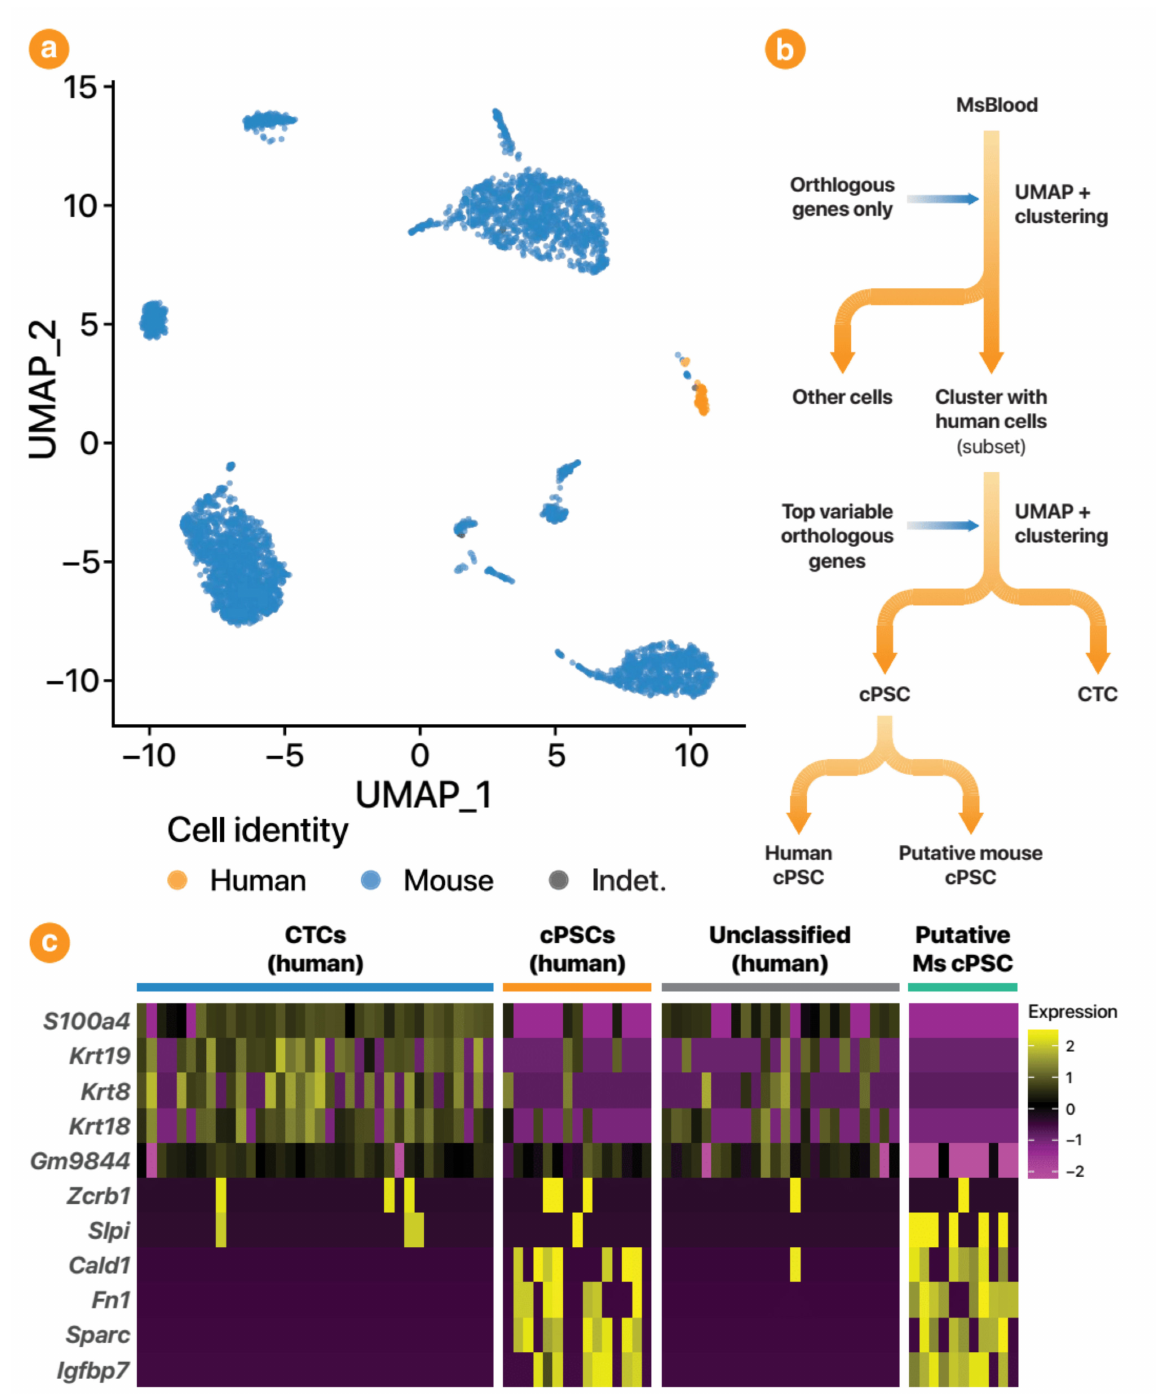
Figure A11. Potential mouse cPSCs in MsBlood sample. ( a ) Gene expression analysis restricted to one-to-one orthologous genes of cells in the MsBlood sample is summarised in the UMAP plot above. Clustering close to the human cells are a number of mouse cells which possibly represent mouse cPSCs. ( b ) This subset of cells were analysed by unsupervised clustering into three groups: PSCs, CTCs and unclassified (non-specific expression pattern). ( c ) Combining the results of cell type classifica-tion with the classification of cell species (mouse versus human), one can infer the identities of putative mouse cPSCs. Abbreviations: Ms, mouse. Indet.,